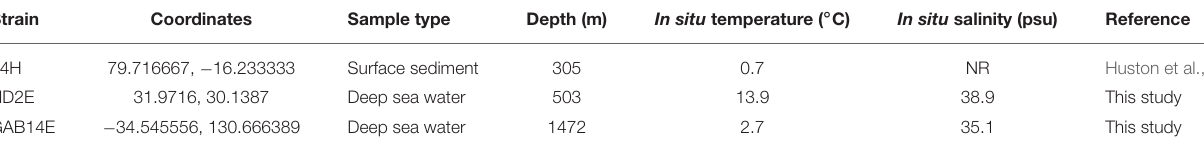
TABLE 1 | Environmental conditions for sampling locations for three C. psychrerythraea . Strain Coordinates Sample type Depth (m) In situ temperature ( ◦ C) In situ salinity (psu) Reference Surface